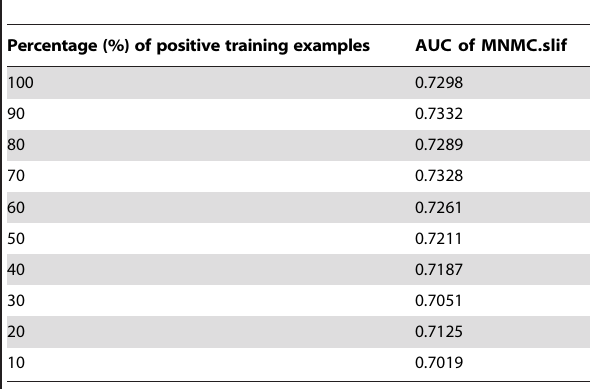
Table 2. Dependence of the prediction performance on the size of positive training sample set.